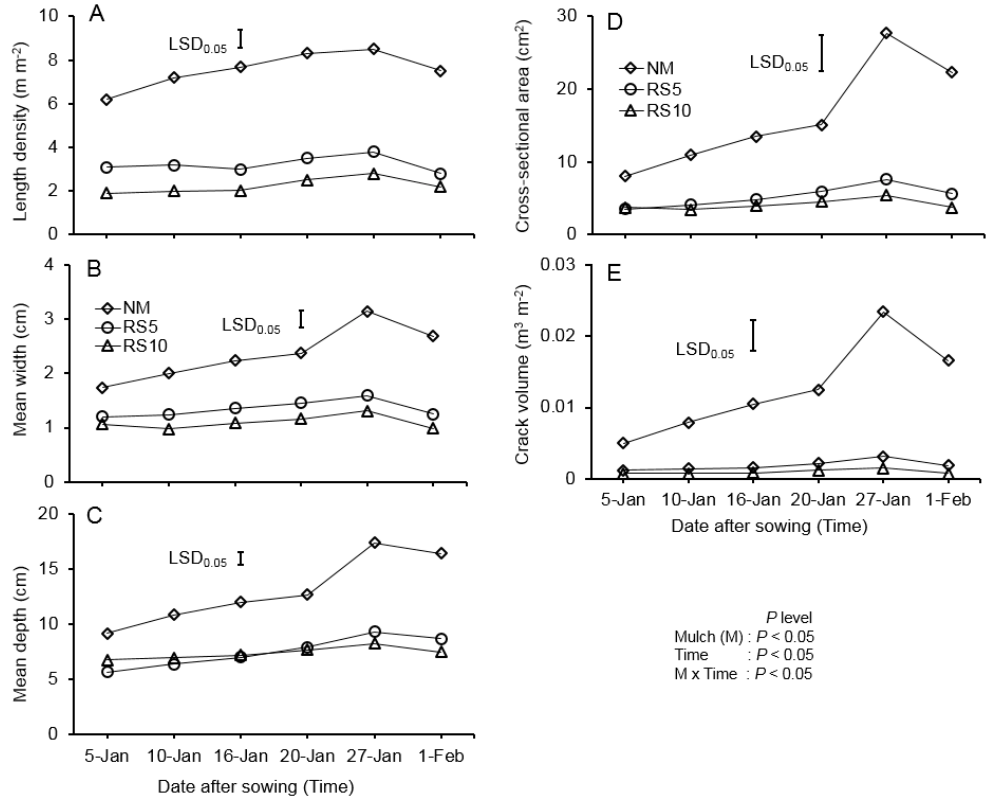
Figure 6. Effects of mulch treatments on crack parameters: ( A ) length per unit area, ( B ) mean width, ( C ) mean depth, ( D ) mean cross-sectional area, and ( E ) crack volume per unit area. LSD 0.05 is the least significant difference of the interaction in each graph between mulch and time at a p -value of 0.05. NM = no-mulch; RS5 = rice straw at ~5 t ha − 1 ; RS10 = rice straw at ~10 t ha − 1 . Note: the sunflower crop was sown on 7 December.